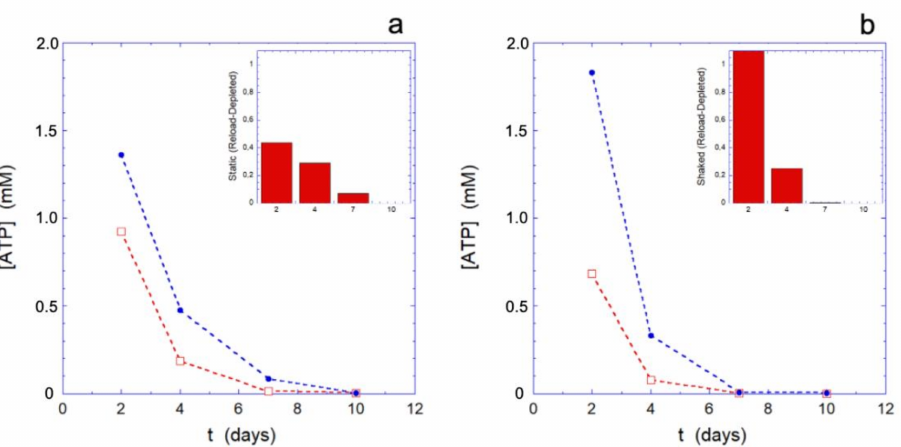
Figure 3. Results of the rejuvenation procedure on static (panel ( a )) and mechanically stimulated (panel ( b )) samples. The red squares represent the intracellular ATP content prior to the rejuvenation procedure, while the blue dots represent the intracellular ATP content immediately after the procedure. Insets are shown inside the graphs, to better highlight the ATP increment during the reload. The ATP concentrations are shown in log